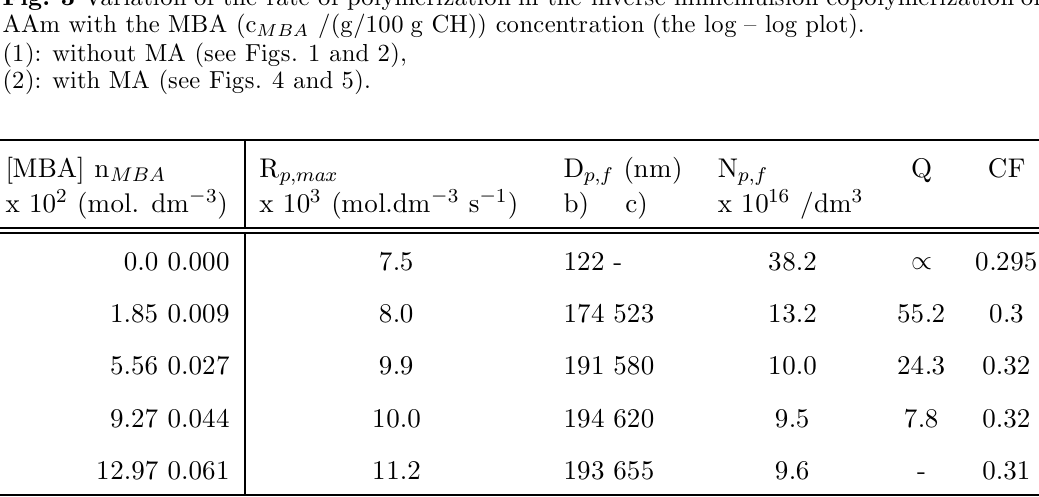
Table 1 Variation of kinetic and colloidal parameters and the swelling index (Q) of AAm/MBA copolymer and contraction factor (CF) in the miniemulsion copolymerization of AAm with the MBA (molar fraction of MBA, n MBA ) concentration. a )